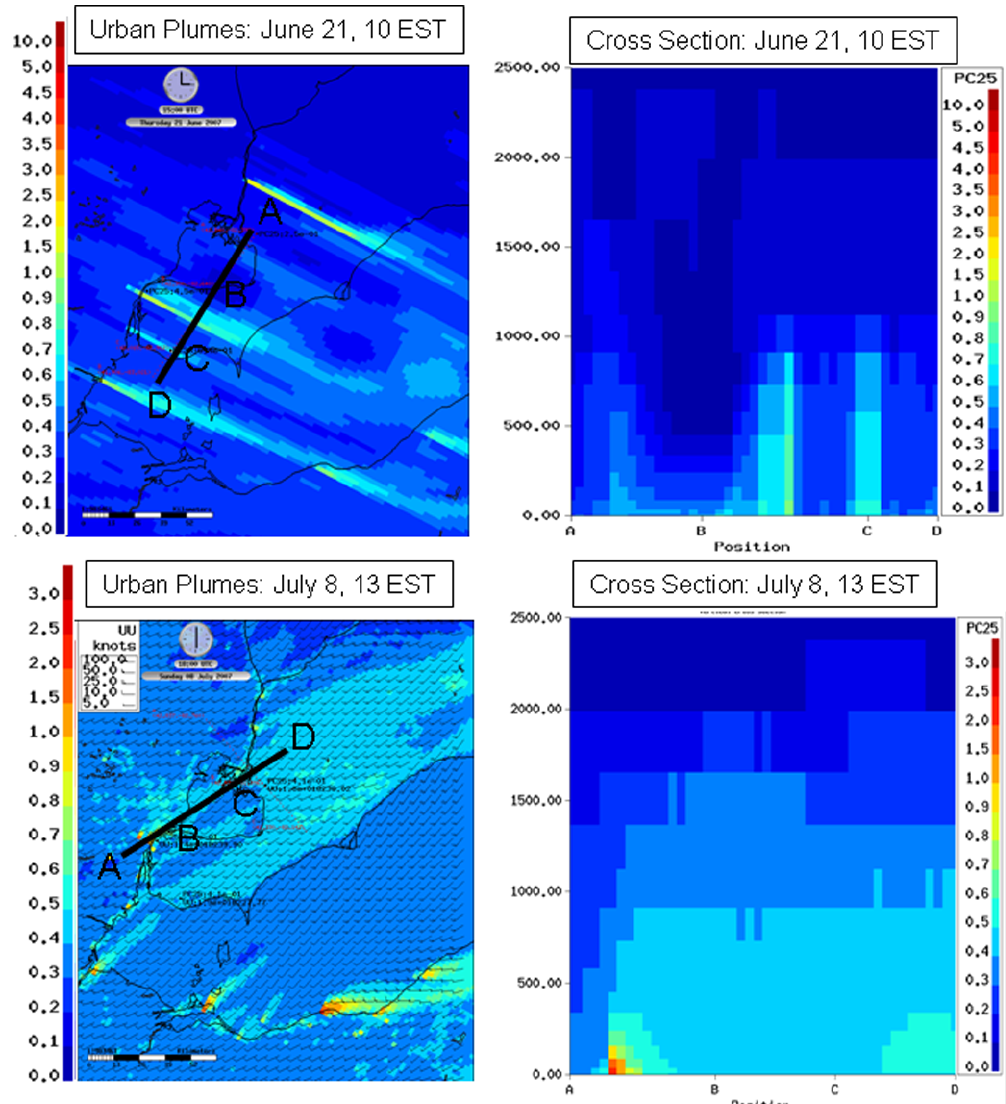
Fig. 7. AURAMS (a) PM 1 POA surface distribution for 21 June 2007 at 10:00EST (upper left) and (b) vertical cross section perpendicular to surface wind direction at Harrow from point A in northeast to point D in southwest (upper right), (c) PM 1 POA distribution with superimposed surface wind vectors for 8 July 2007 at 13 EST at Bear Creek (lower left) and (d) vertical cross section parallel to surface wind direction from point A in southwest to point D in northeast (lower